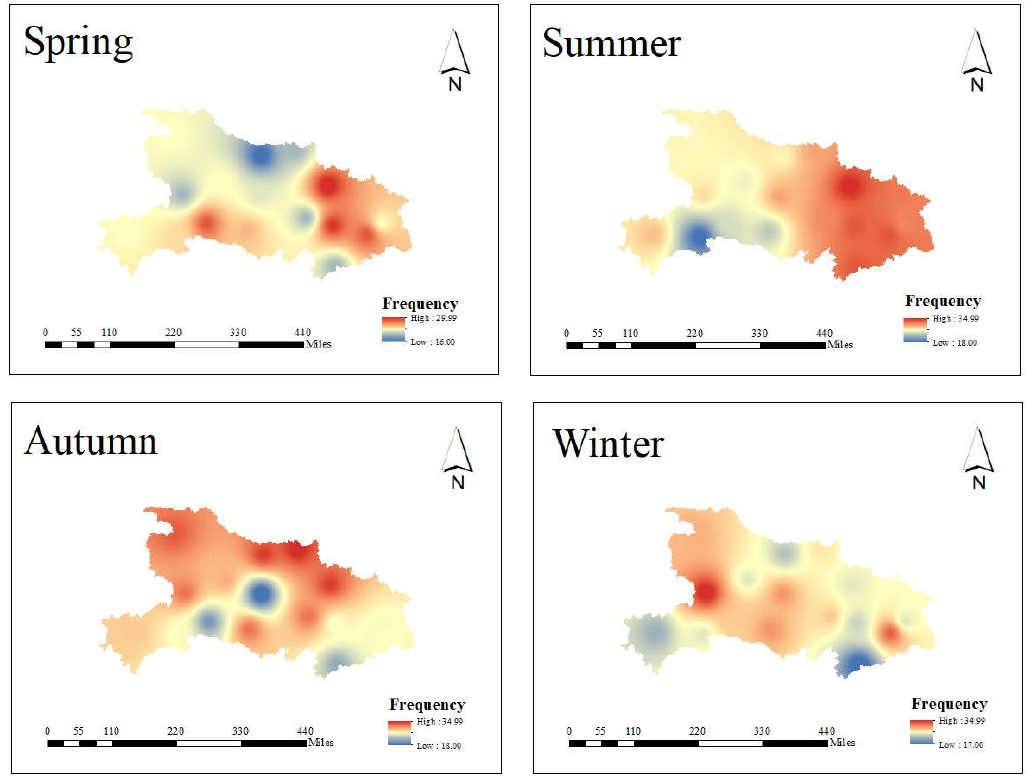
Figure 4. Spatial distribution of drought (D1-D4) frequency in each season for Hubei Province.